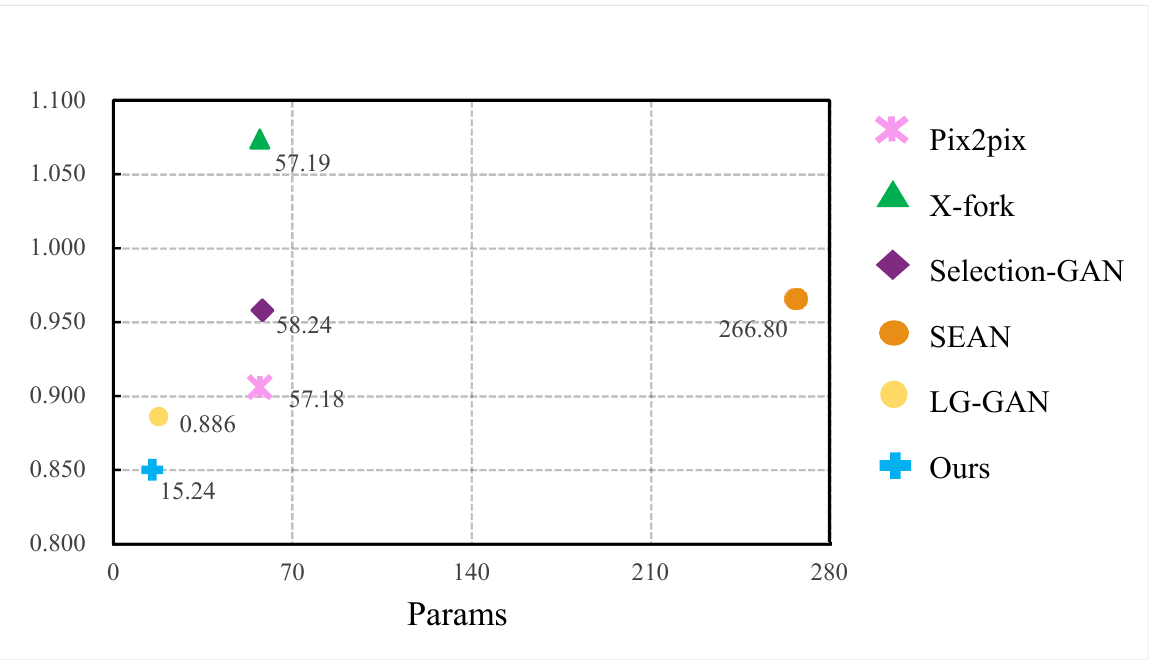
Figure 6. Compared with the computational efficiency of advanced algorithms.